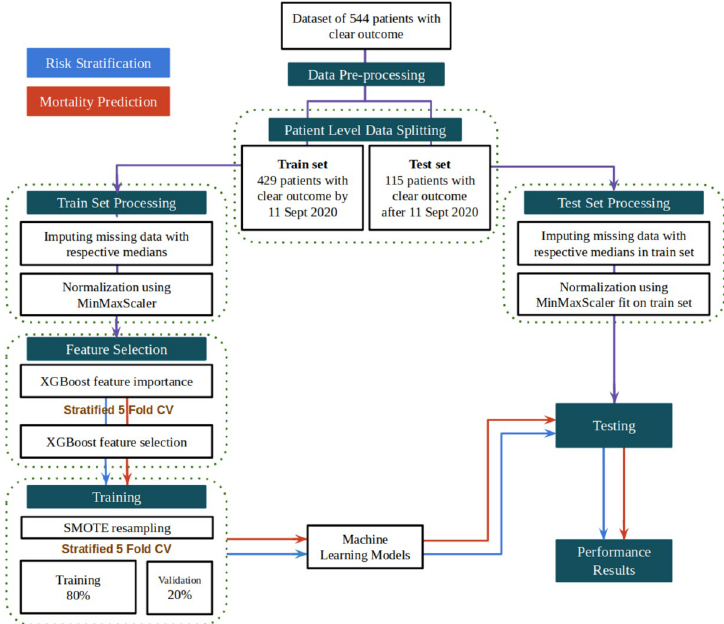
Fig 1. Machine learning pipeline for the development of the risk stratification and mortality